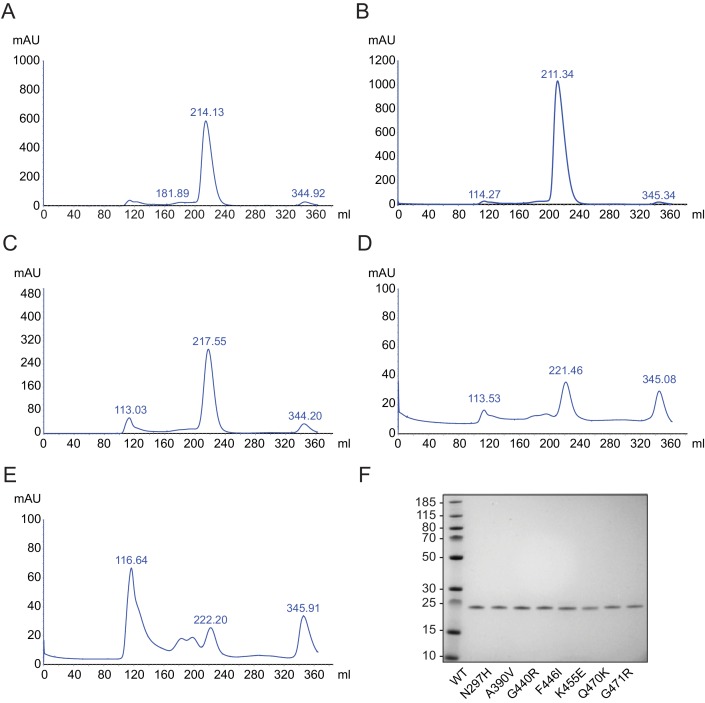
Purification of TRIM21 PRYSPRY protein.(A–E) Superdex 75 (HiLoad 16/60) size exclusion chromatograms for a selection of TRIM21 PRYSPRY variants. (A) WT. (B) N297H. (C) A390V. (D) G440R. (E) F446I. (F) Variant TRIM21 PRYSPRY proteins resolved by 4–12% SDS-PAGE developed in MES-SDS buffer and stained using InstantBlue.